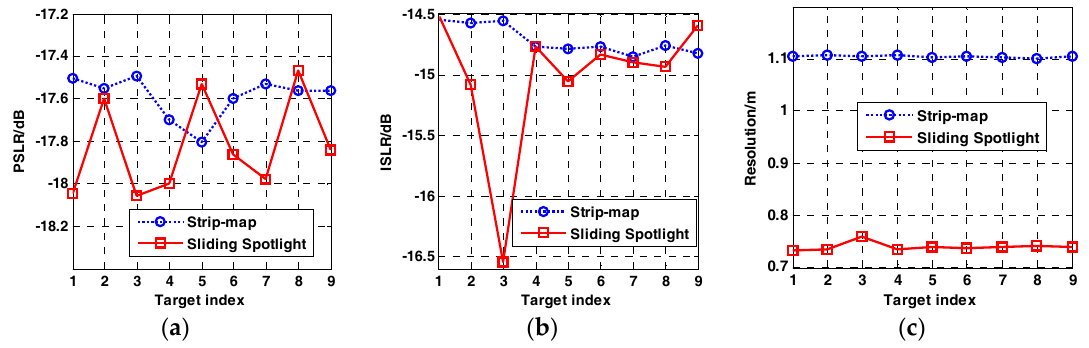
Figure 16. Distribution of focusing performances for SAR data with mild motion error. ( a – c ) are the distributions of PSLR, ISLR, and resolution, respectively. The blue dashed line and red one are the results of strip ‐ map and sliding spotlight, respectively.